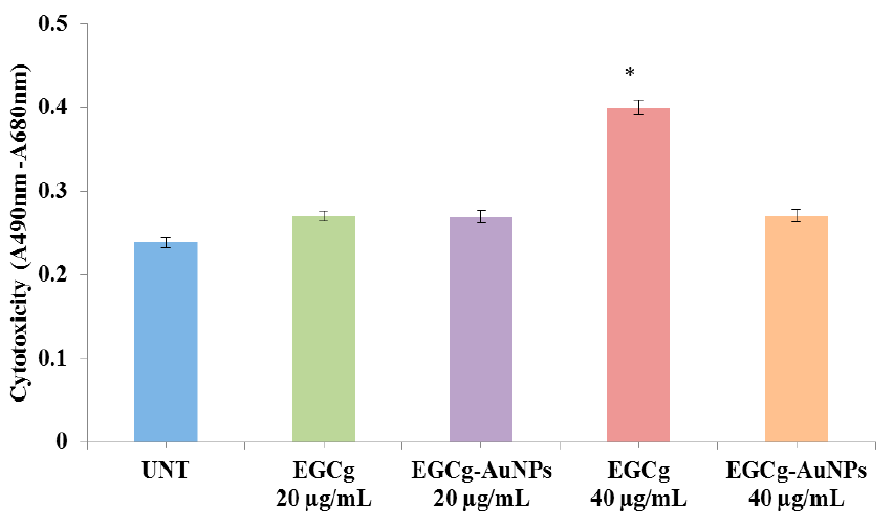
Figure 7. Cytotoxic effect of EGCg-AuNPs and free EGCg on human aortic endothelial cells (HAECs) with 24 h incubation time (mean ± SE; n = 3). * p < 0.05 vs. EGCg-AuNPs at same concentration.